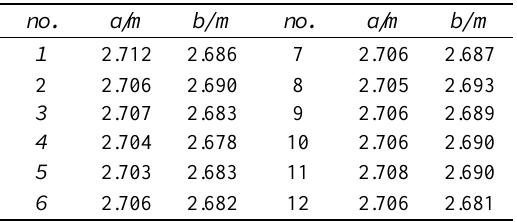
Table 4. The long and short axis of fitting ellipse(d=2.0m)